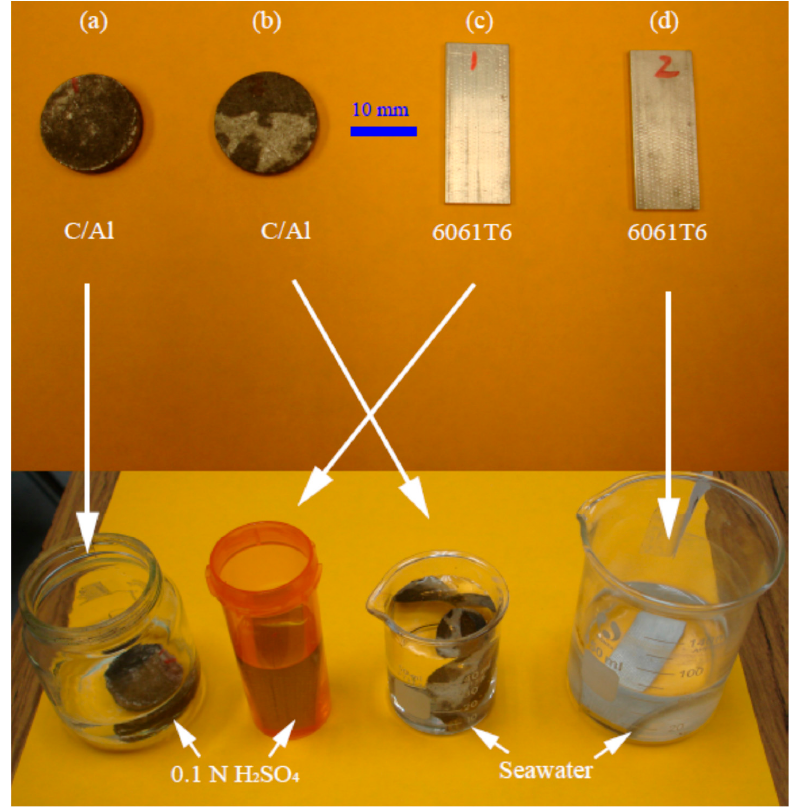
Figure 5. The immersion corrosion test set-up including the specimens and the solutions used.